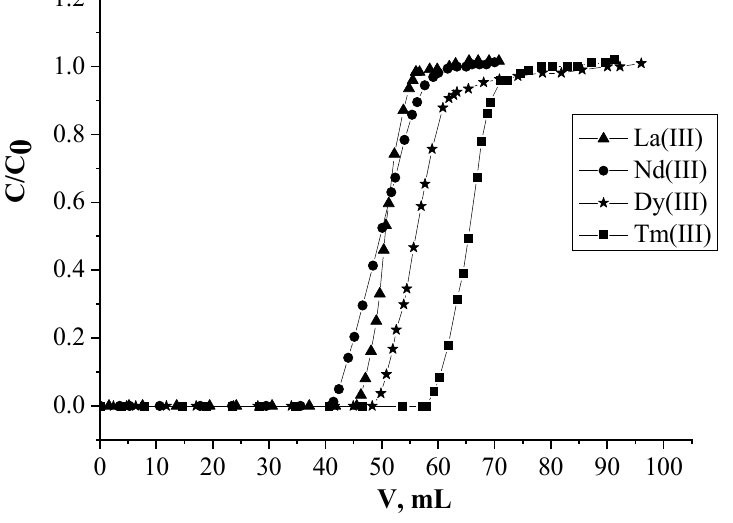
Figure 6. Frontal loading curves of La(III), Nd(III), Dy(III) and Tm(III) in HNO 3 of 0.01 mol/L.